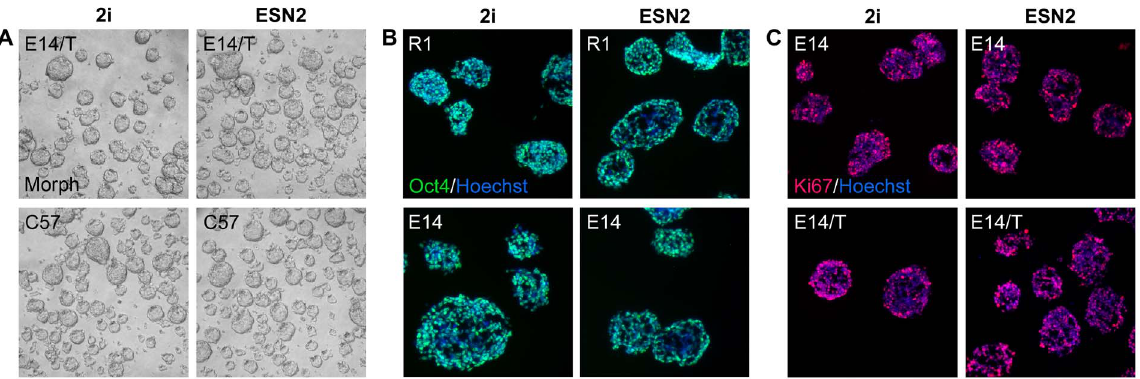
Figure 2. Phenotypc analysis of free-floating mouse ES cell sphere morphology as assessed by phase-contrast microscopy and immunochemistry. Phase-contrast micrographs of spheroid morphology (A) and fluorescence micrographs of Oct4 (B) and Ki67 (C) immunohistochemical detection of Oct4 and Ki67 in cryosectioned spheroids of mES cells grown in 2i or ESN2 media.